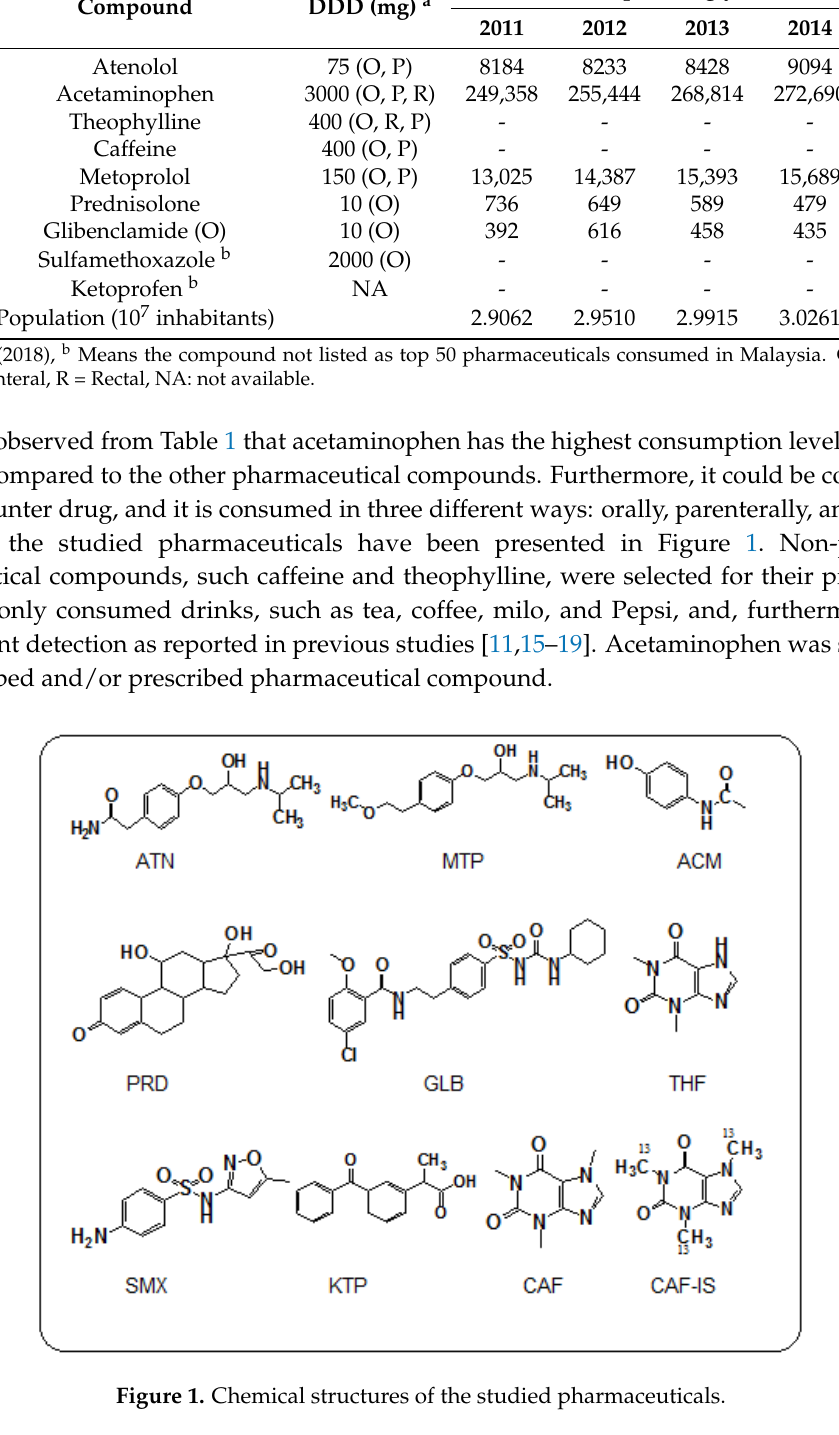
Table 1. Defined daily doses (DDD) and the consumption of the selected pharmaceuticals in Malaysia (MOH 2014).